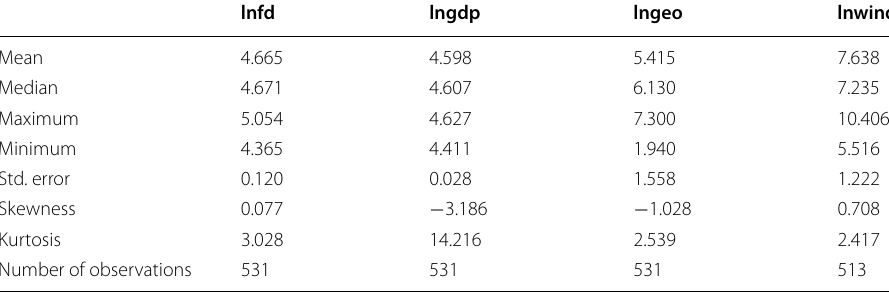
Table 1 Descriptive statistics of the variables